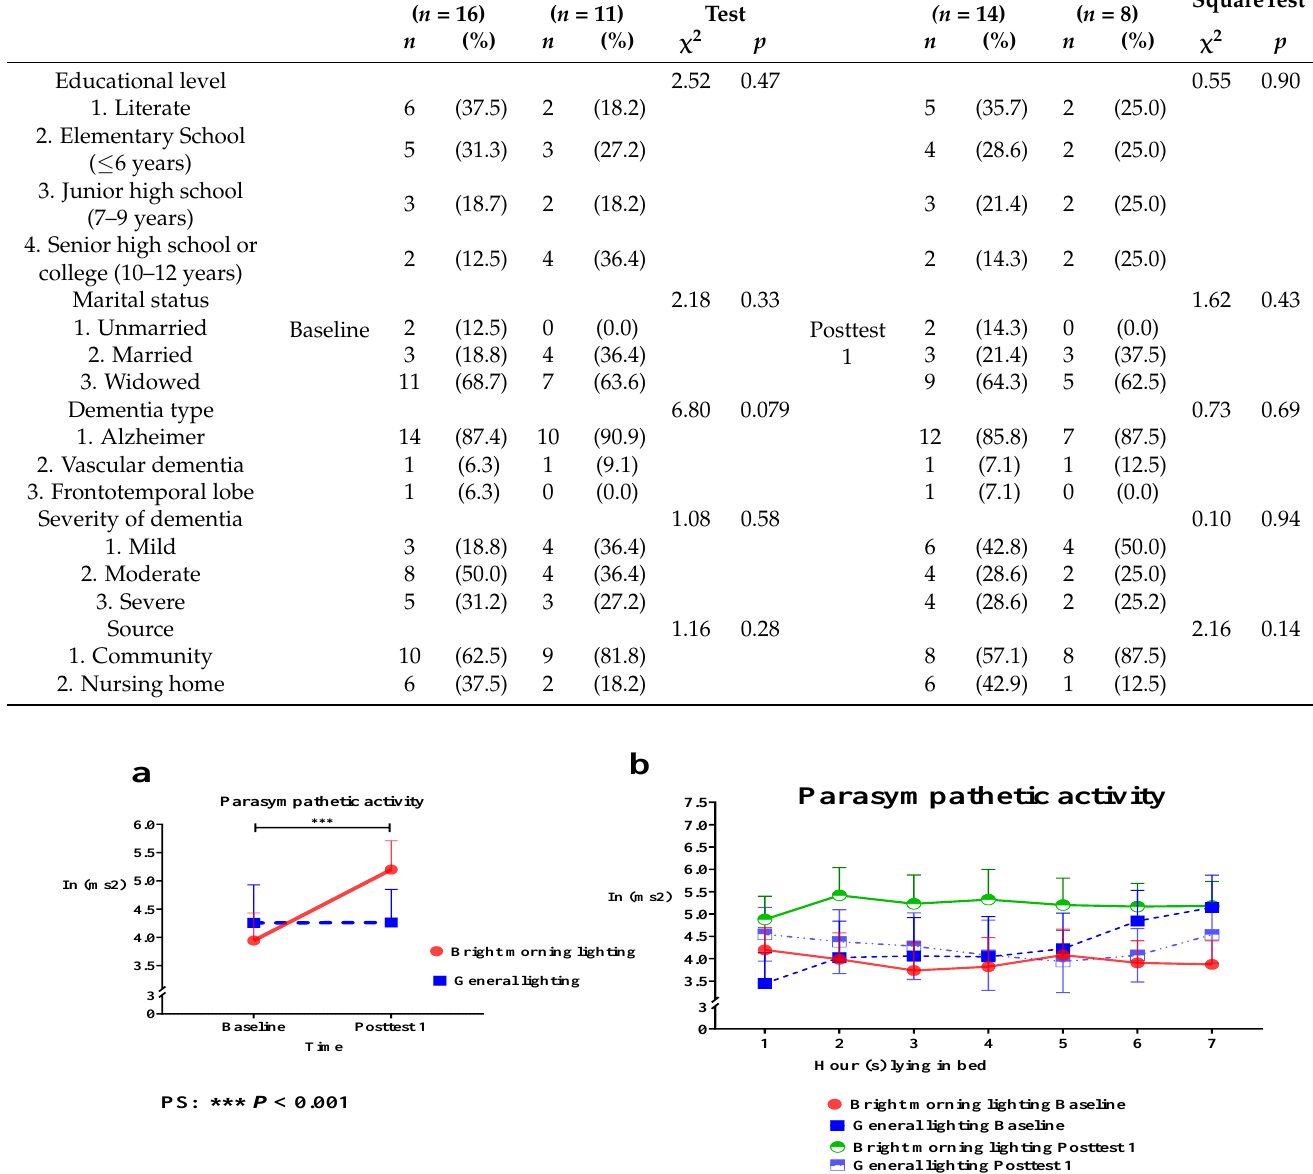
Figure 3. ( a ) Changes in parasympathetic nervous system (PSNS) activity in both the treatment and control groups while lying in bed for 7 h. PSNS activity shows a significantly different high-frequency power (HF) component from baseline to posttest 1 in the treatment group compared with the control group ( p < 0.001). ( b ) The BML group demonstrated a sustained peak in HF power while lying in bed for 2–4 h. Specifically, the BML group had an increased peak in HF power at 2 h at posttest